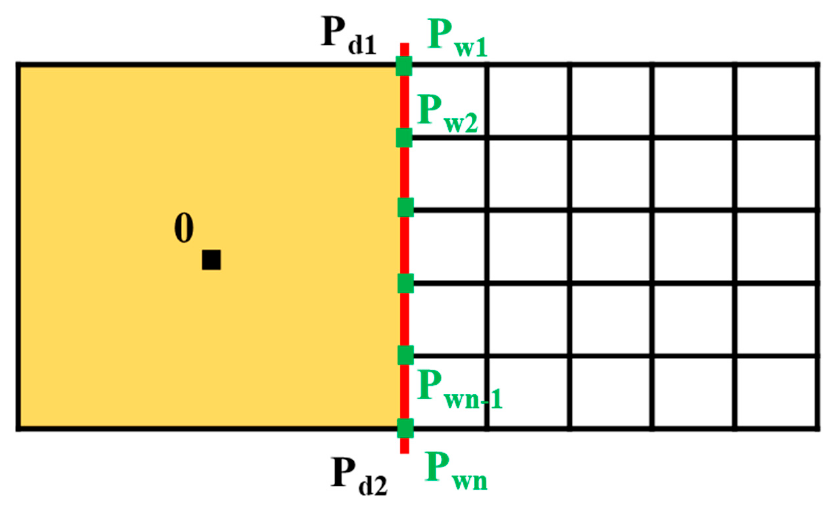
Figure 3. The variable interpolations between the coarse and fine grids. The coupling algorithm between the SWEs and DWEs based on the coarse and fine grids is presented in Figure 4.